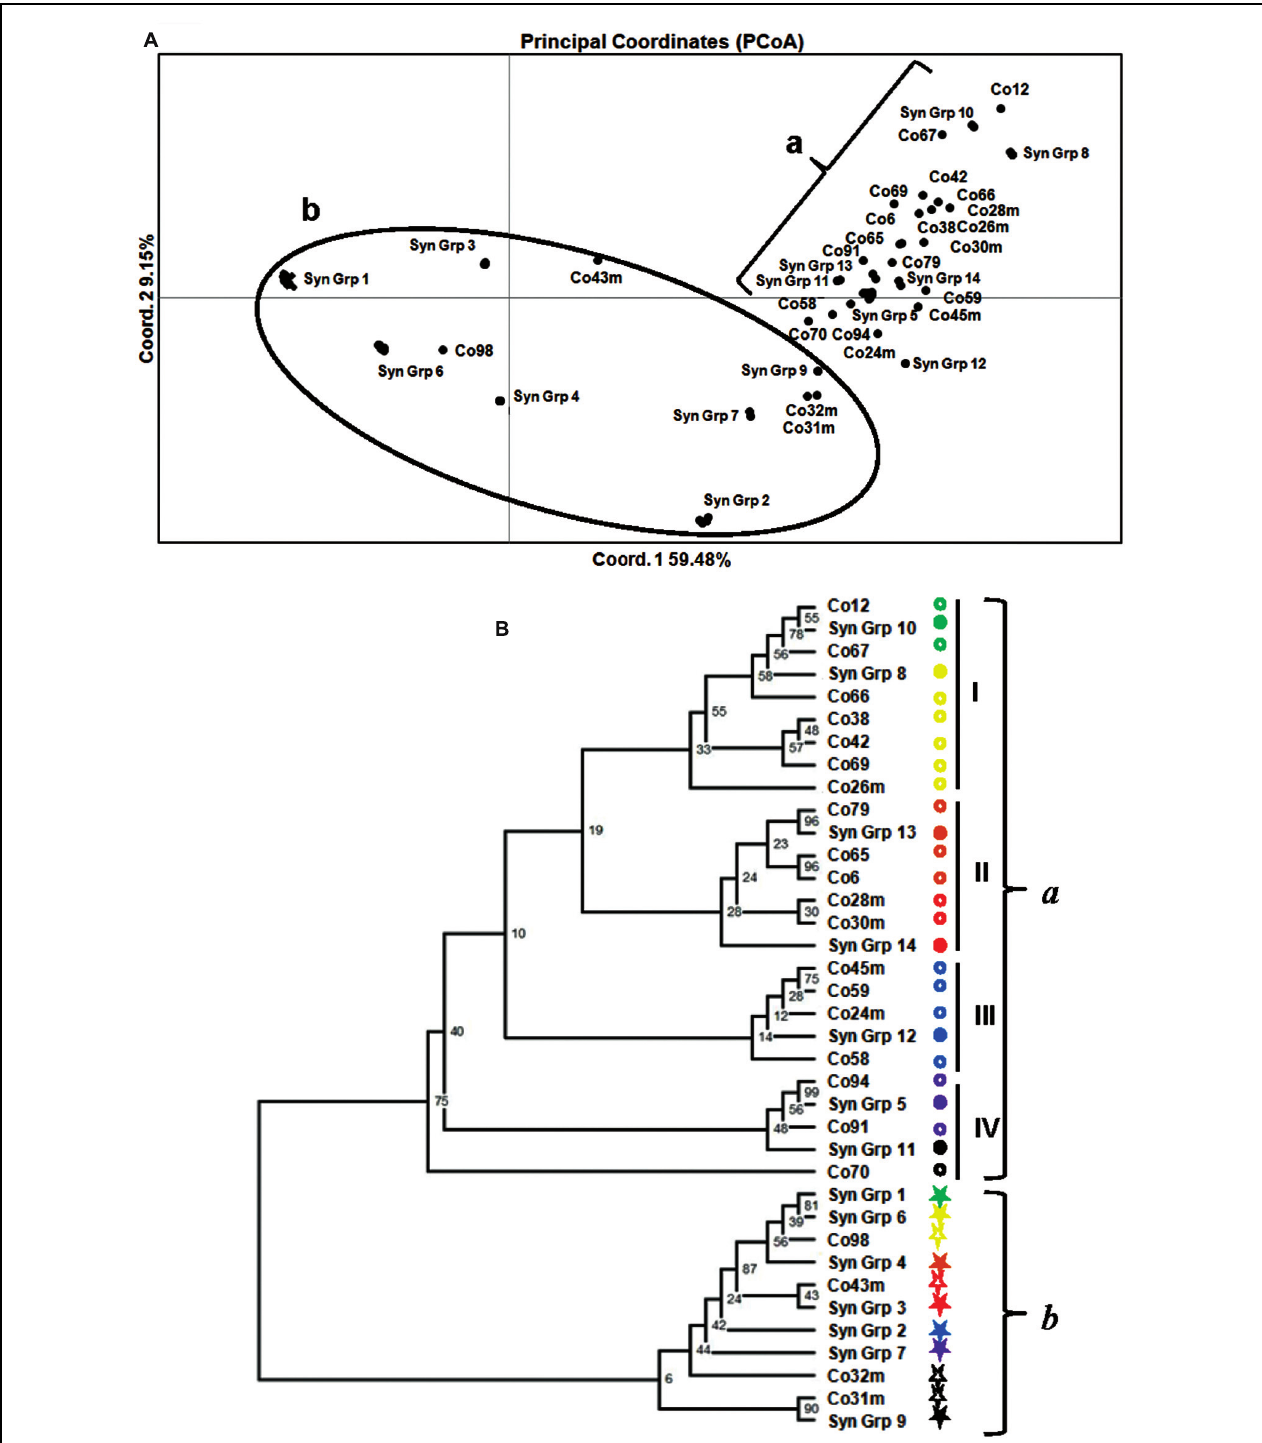
FIGURE 3 | Genetic relationships based on 88 SNP markers among 172 M. roreri isolates collected from frosty pod rot affected areas of South and Central America. (A) Principal Coordinates Analysis based on the pairwise distance matrix. The plane of the first three main PCO axes accounted for 75.1% of total variation. First axis = 59.48% of total information, the second = 9.15%, and the